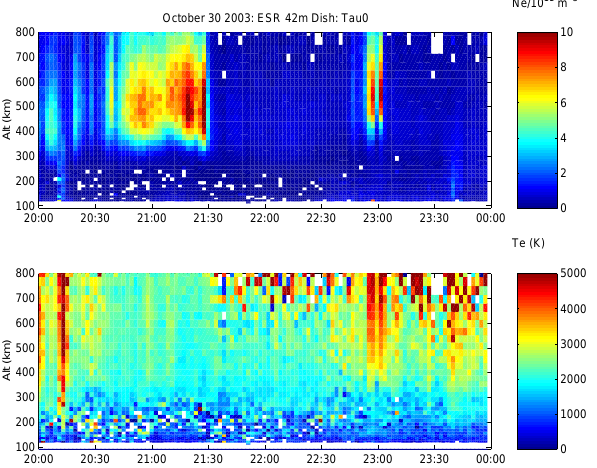
Fig. 2. Electron densities (upper panel) and electron temperatures (lower panel) measured by the EISCAT Tromsø (69 ◦ N, 19 ◦ E) radar between 20:00 and 24:00UT on 30 October 2003.